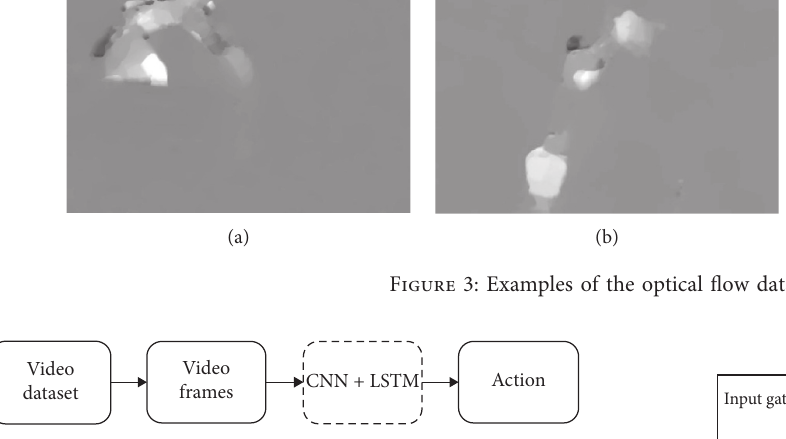
Figure 4: Flow chart for the process of construction equipment action recognition.